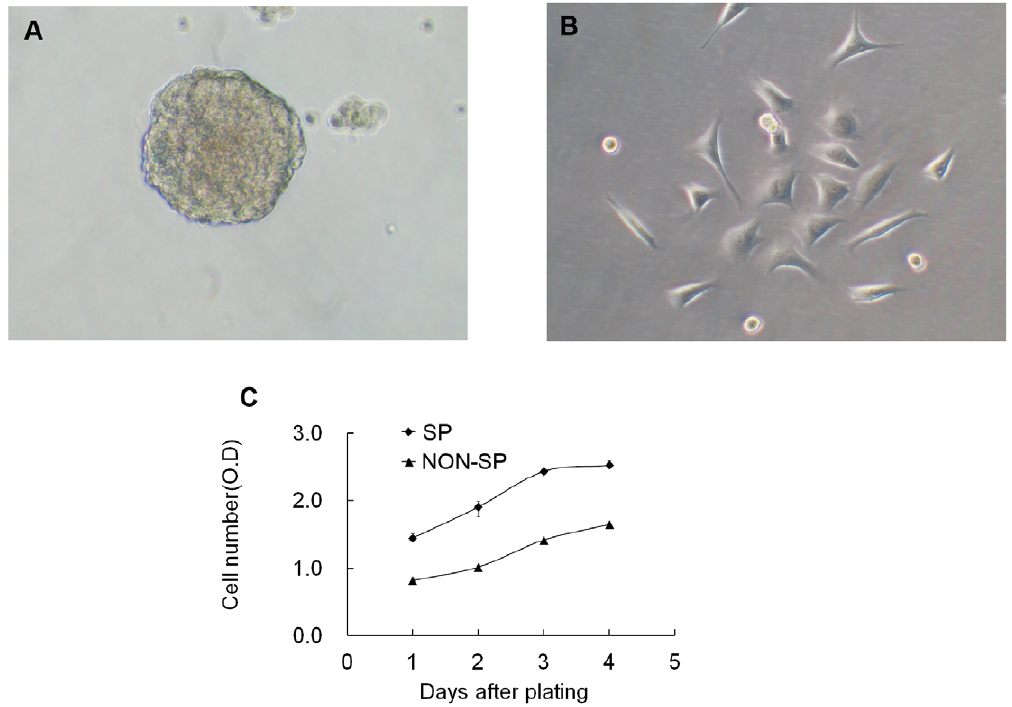
Figure 2. Sphere formation and proliferative capacity of H460 SP and non-SP cells. A–B, Purified SP and non-SP cells were cultured in serum-free medium in anchorage-independent conditions. The SP cells formed typical floating spheres within 4 days (A) whereas the non-SP cells largely established adherent growth (B). C, The SP cells displayed higher proliferative ability than non-SP cells as determined by CCK-8 kit ( P , 0.05 for all time points, Student t